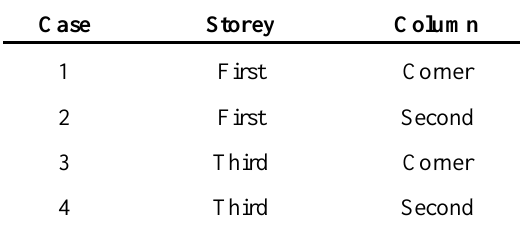
Table 2. Column removal cases in 5-storey frame.